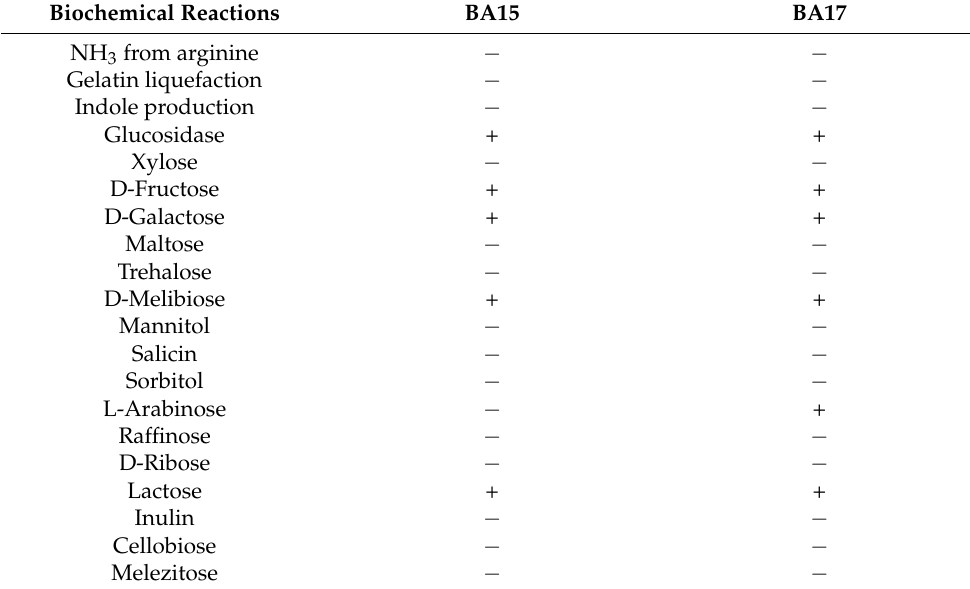
Table 3. Biochemical profile exhibited by the Bifidobacterium asteroides BA15 and BA17 strains.